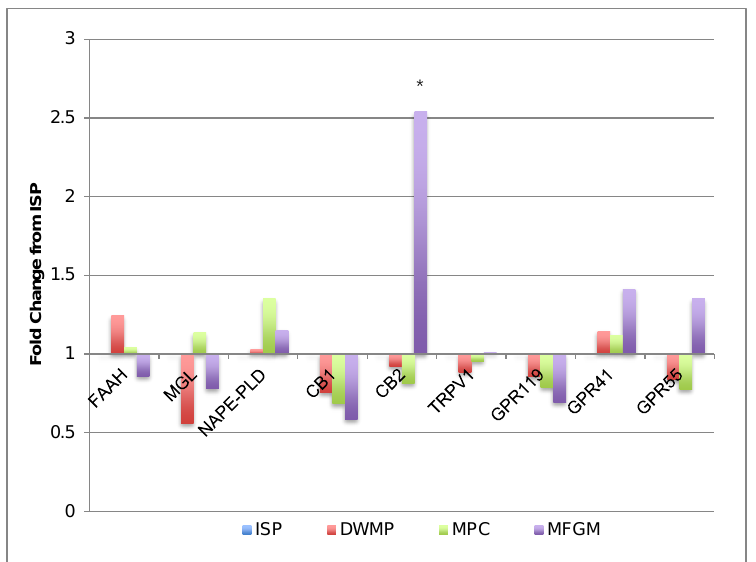
Figure 3. Intestinal gene expression: cannabinoids and endocannabinoids. Gene expression data were from small intes- tines of n = 5/diet; fold increases were considered significant if at least 2-fold different from the ISP comparator and are denoted by the use of “*”. CB2 was increased 2.5-fold in intestines from milk fat globule membrane (MFGM)-fed mice compared to ISP. Other CB and eCB genes were unchanged. Figure 4 shows that intestinal AP2 (adipocyte protein 2, also known as FABP4 ) gene expression was increased 2.76-fold and SREBP-1c expression increased 2-fold in MFGM Nutrients 2021 , 13 , x FOR PEER REVIEW fed mice compared to ISP-fed mice; DWMP- and MPC-fed mice showed similar expres- sion when compared to ISP-fed mice. Conversely, intestinal PPARγ and FASN gene ex- pression in MPC-fed mice was 2-fold and 2.3-fold lower than that of ISP-fed mice, respec- tively. Expression of these same genes was similar to ISP in DWMP and MFGM. Adipo- cyte differentiation ( C/EBP , PPARγ and lipogenesis gene ( ACC ) expression were similar among diet treatments.